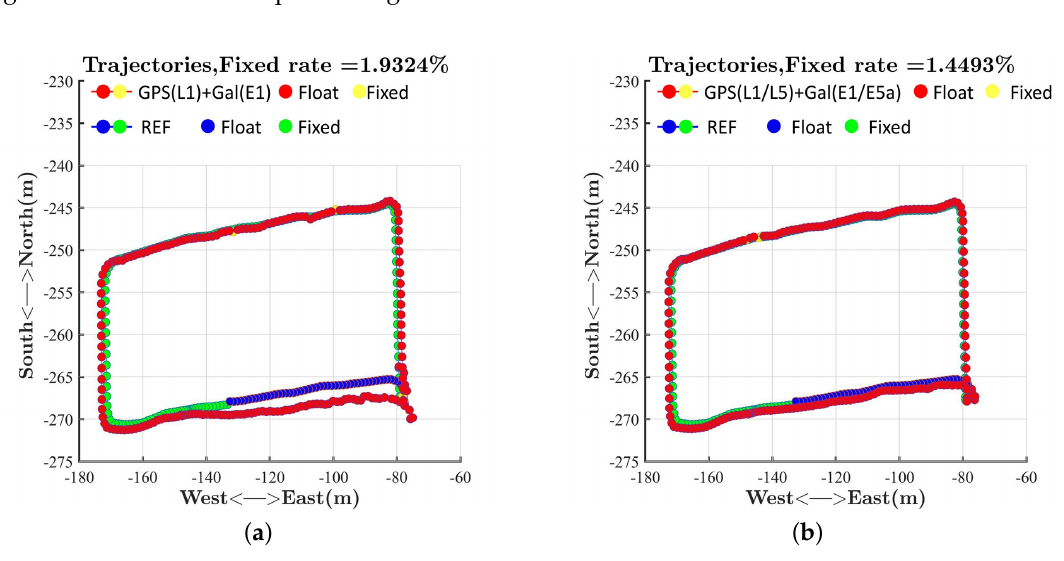
Figure 10. RTK performances on the basketball court. ( a ) GPS(L1) + Galileo(E1); ( b ) GPS(L1 + L5) + Galileo(E1 +